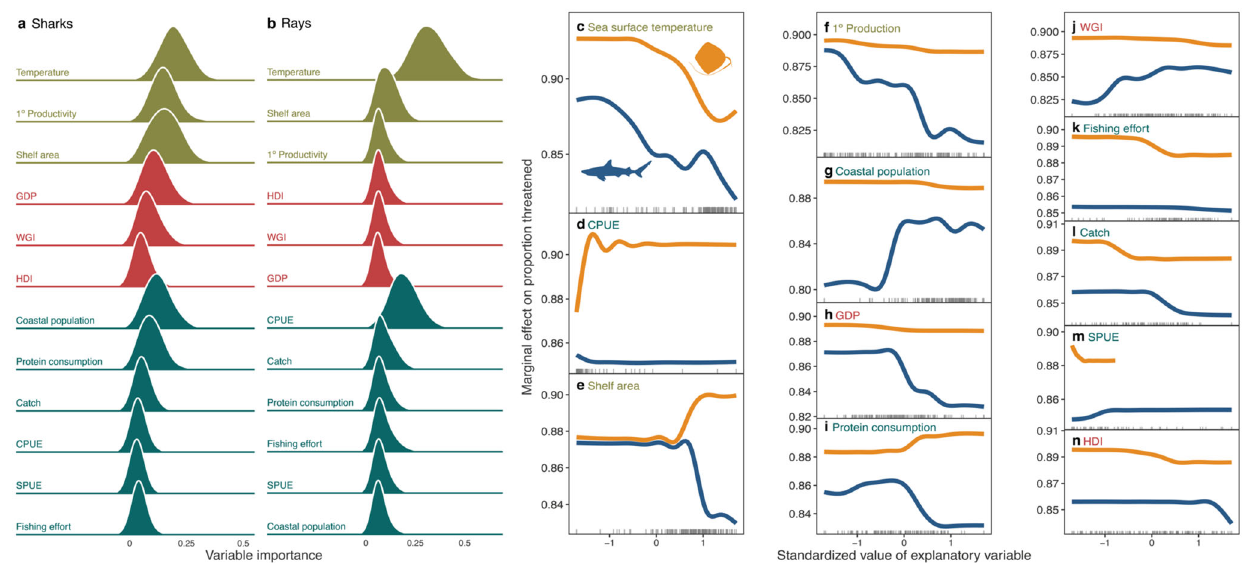
Fig. 3 | National attributes also explain extinction risk. Variable importance for explaining proportion of threatened species of all covariates across 1,000 boot- strapped boosted regression tree models for a sharks and b rays. The marginal effect c – n of each variable on the proportion of threatened species for rays and sharks ordered by variable importance. Explanatory variables were all scaled and centred around zero for presentation purposes; raw values were used in